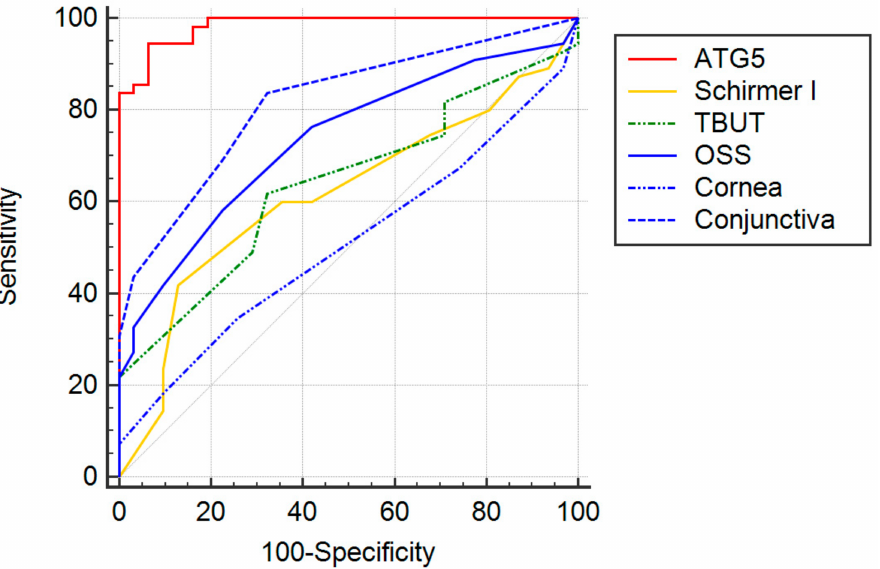
Figure 1. Receiver operating characteristic (ROC) curves for different parameters. The greatest area under the curve (AUC) was found for tear ATG5 (0.984, 95% confidence interval (CI), 0.930 to 0.999), followed by the conjunctiva staining score (0.817; 95% CI, 0.719 to 0.892), the OSS score (0.734; 95% CI, 0.628 to 0.824), the TBUT (0.640; 95% CI, 0.529 to 0.741), the Schirmer I test (0.616; 95% CI, 0.505 to 0.719), and the cornea staining score (0.508; 95% CI, 0.398 to